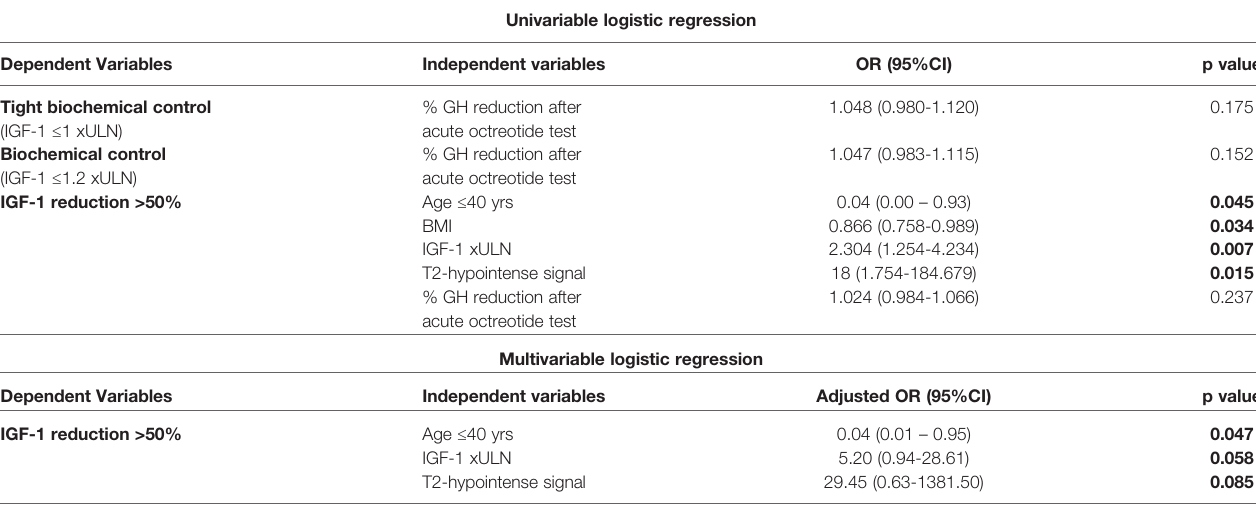
TABLE 2 | Univariable and multivariable logistic regression analysis to predict biochemical control.